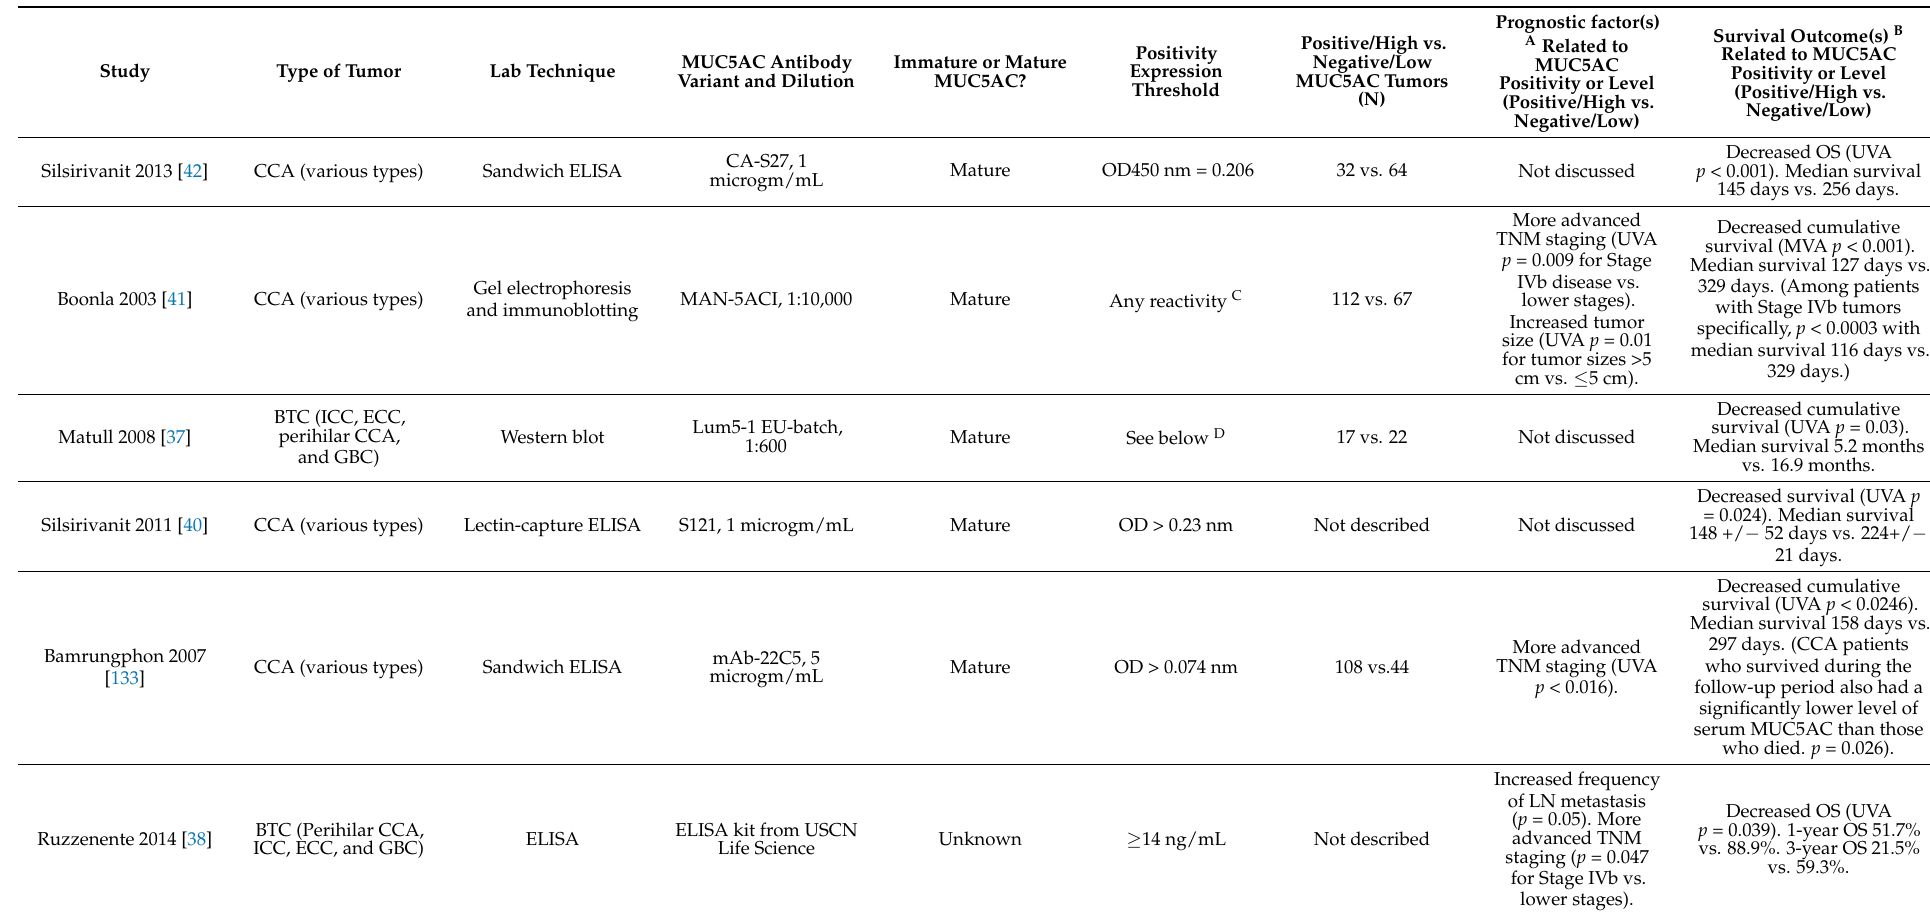
Table 5. Studies evaluating the prognostic impact of MUC5AC expression in BTC